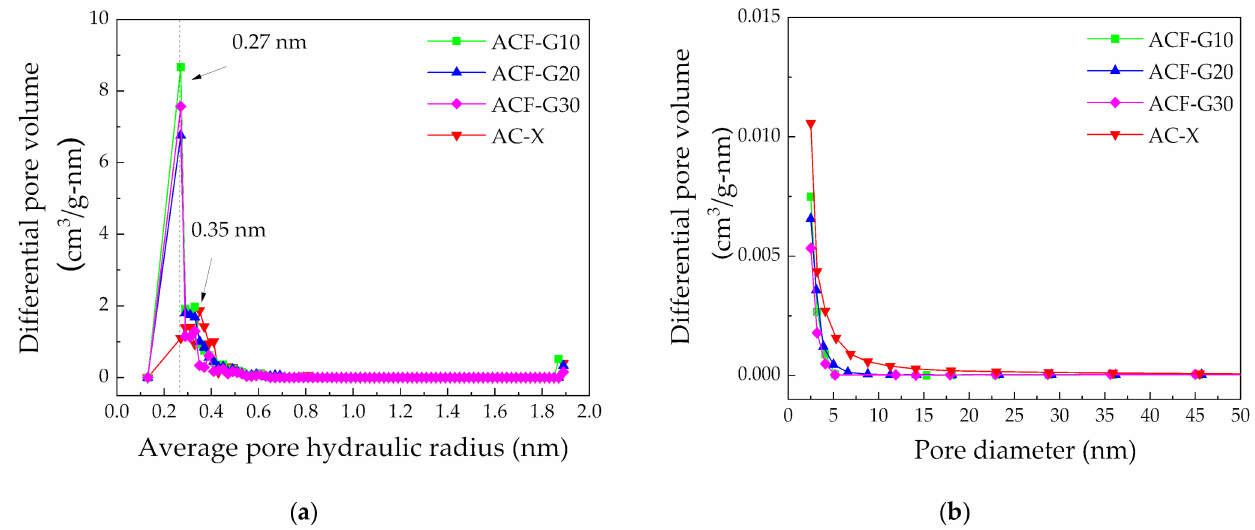
Figure 5. Pore size distribution of the catalysts calculated using the ( a ) MP and ( b ) BJH